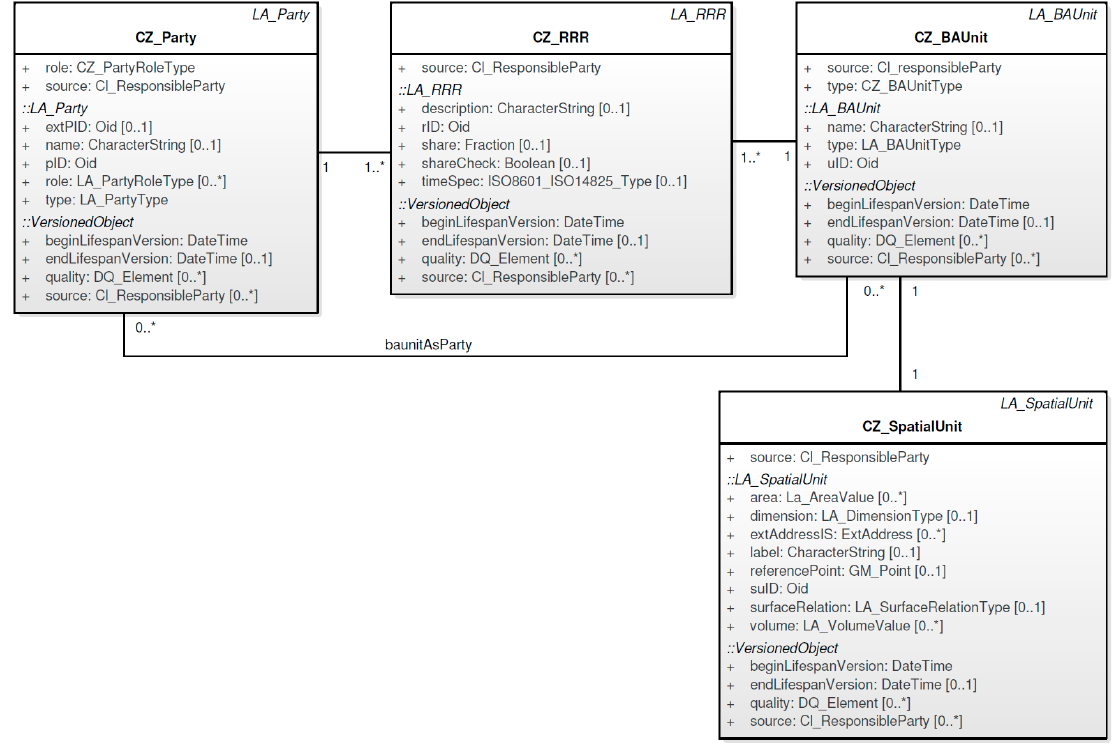
Figure 3. The four fundamental classes of the Czech LADM-based profile.